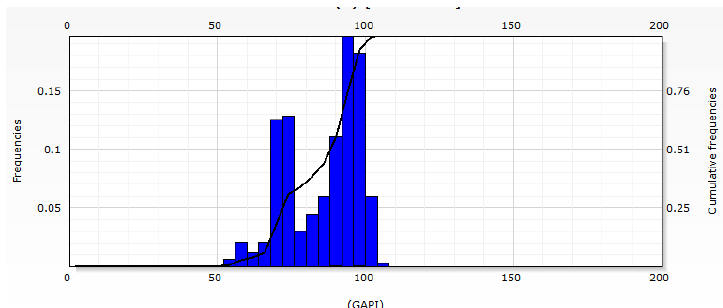
Fig. 5 Frequency histogram of GR curve of well a.